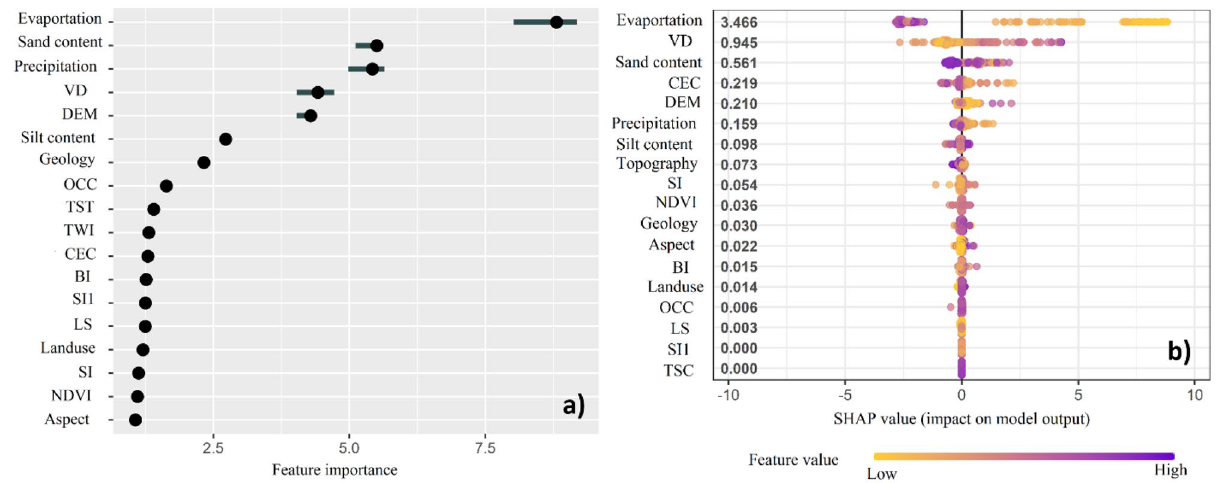
Figure 9. ( a ) The relative importance of factors controlling soil salinity determined by: ( a ) PFIM, and; ( b )